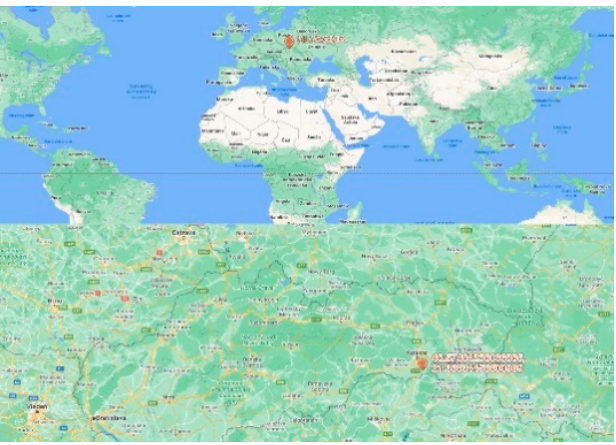
Figure 1. Geographic location (based on equator) of samples collection region (GPS) .